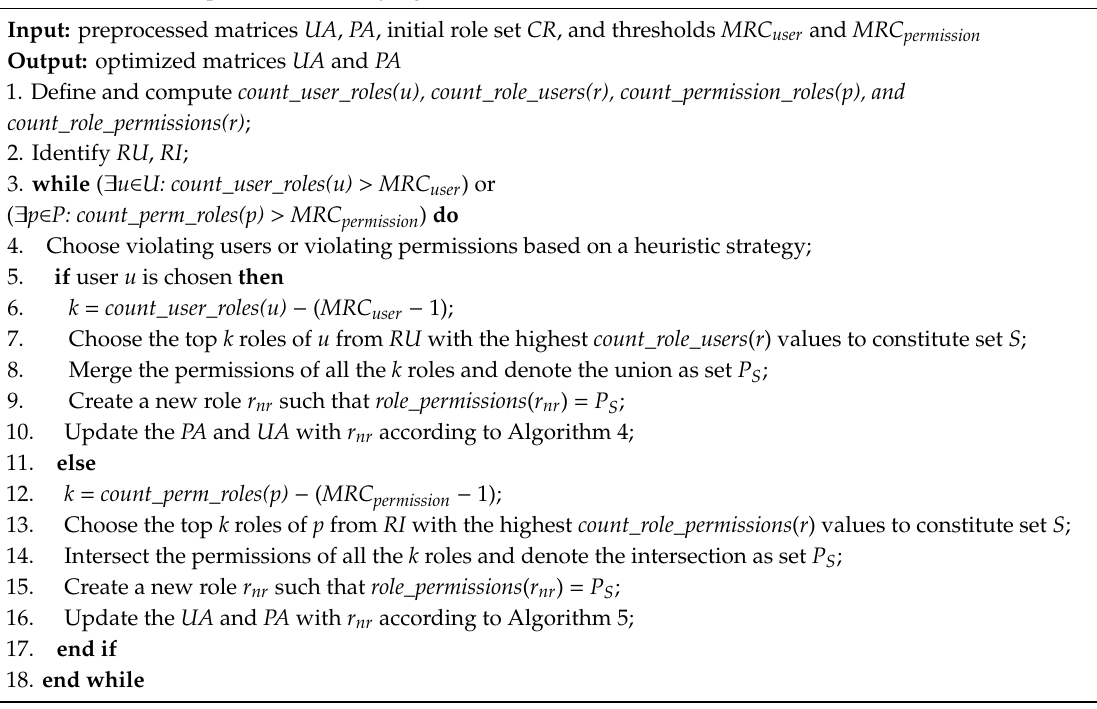
Algorithm 6. Role optimization satisfying both UCC and